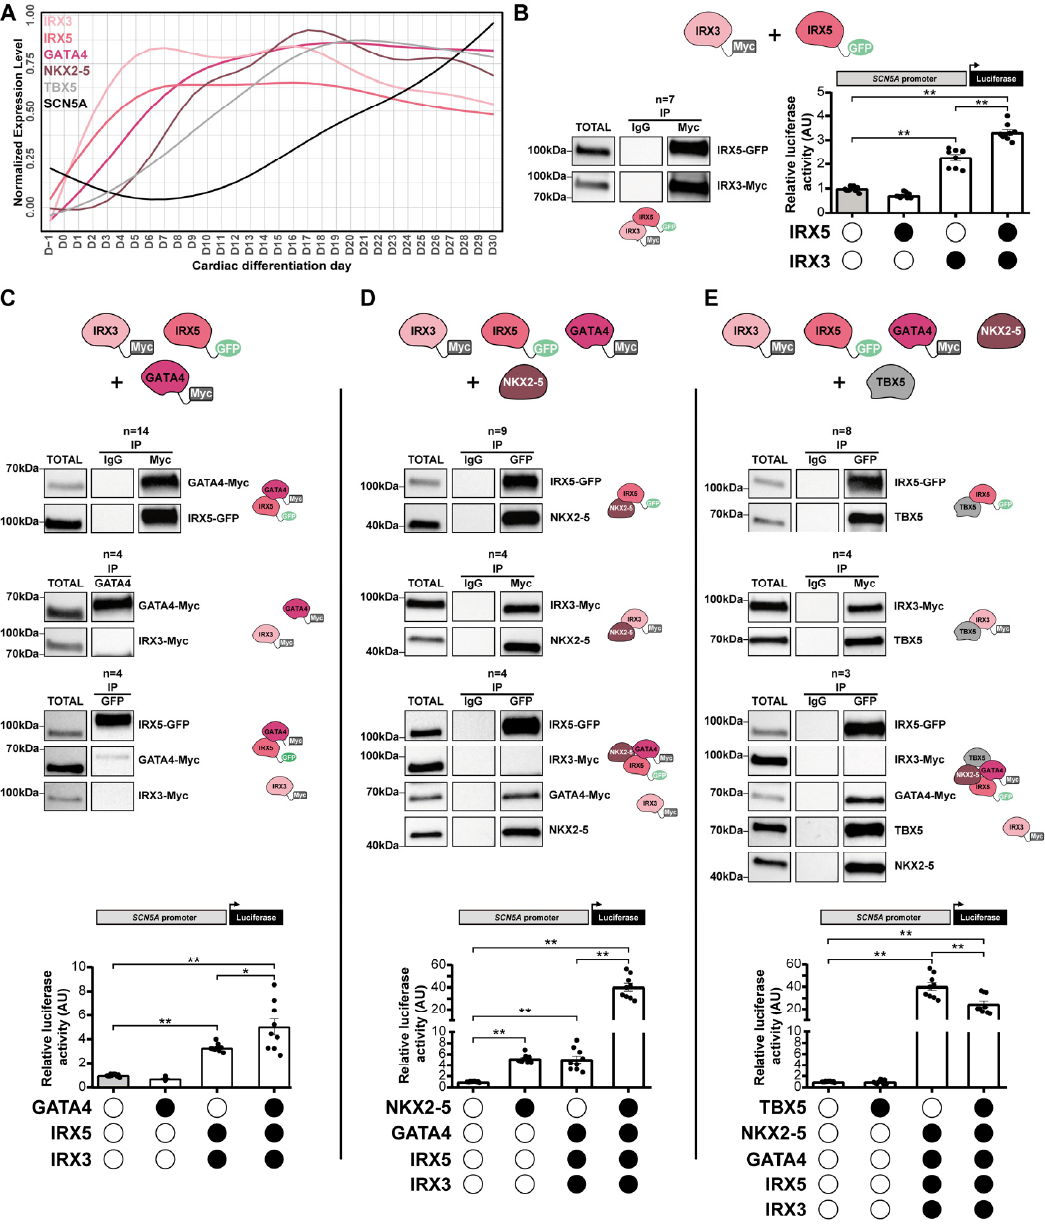
Figure 6. Physical and functional interactions of IRX3/IRX5/GATA4/NKX2 ‐ 5/TBX5 multiprotein complex. ( A ) Normalized mean expression level overtime of IRX3, IRX5, GATA4, NKX2 ‐ 5, TBX5 and of SCN5A ion channel genes. UPM: UMI per million. ( B – E ) Co ‐ immunoprecipitation and lu ‐ ciferase results associated to the transfection of ( B ) IRX3 and/or IRX5, ( C ) IRX3, IRX5 and/or GA ‐ TA4, ( D ) IRX3, IRX5, GATA4 and/or NKX2 ‐ 5, ( E ) IRX3, IRX5, GATA4, NKX2 ‐ 5 and/or TBX5. Im ‐ munoblots representative of the various co ‐ immunoprecipitations and the schematic illustration of the results. Graphs display activity levels of luciferase that is under the control of the ‐ 2109/+1072